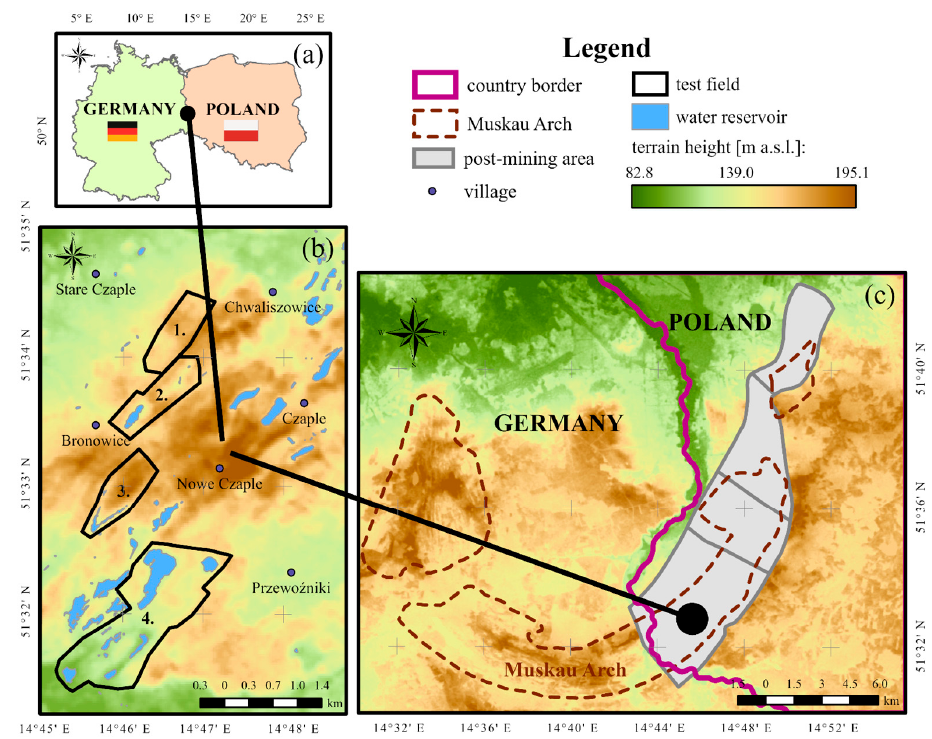
Figure 1. General location of the study area: ( a ) location of the Muskau Arch ( b ) test field three; ( c ) extent of the Muskau Arch.